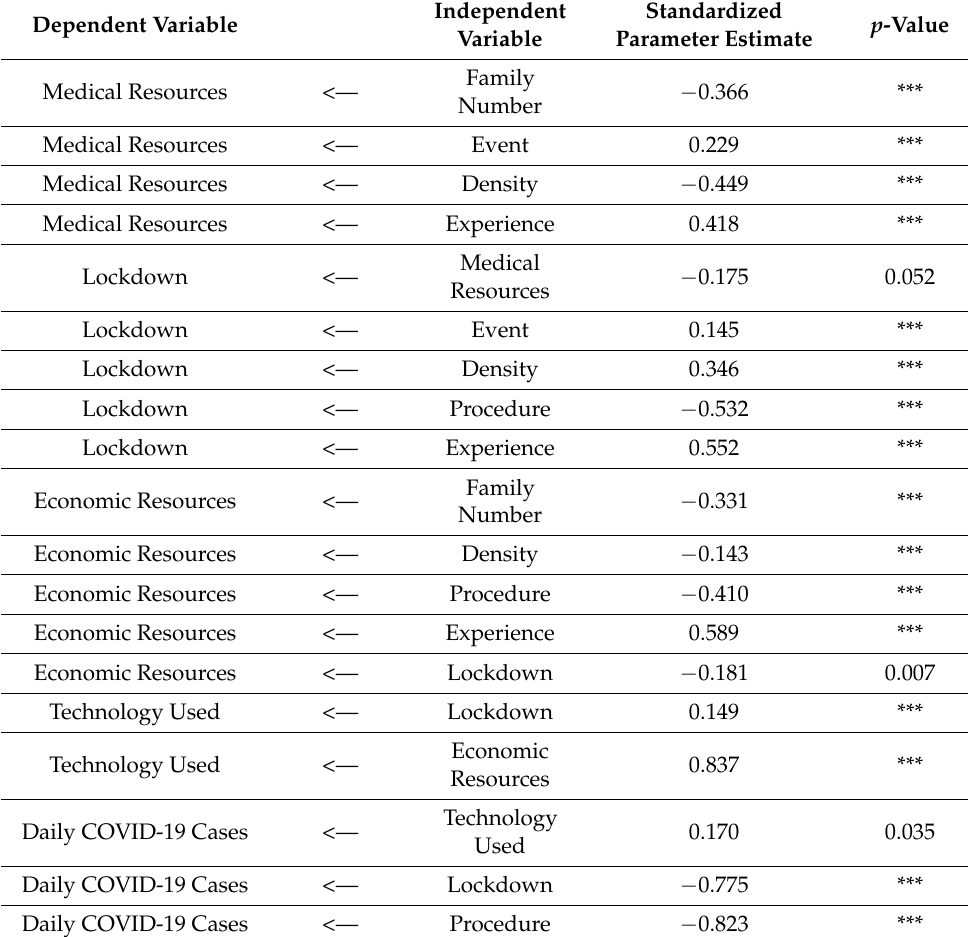
Table 6. Estimated parameters for all factors. *** p -Value < 0.001.